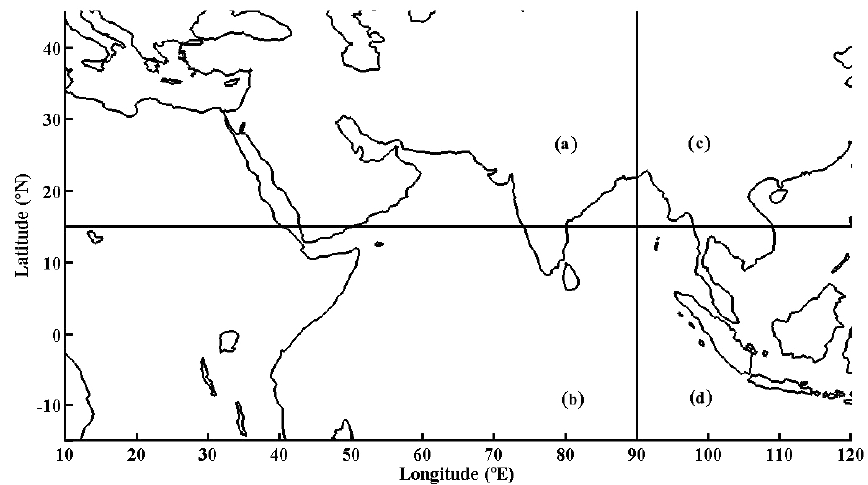
Figure 5. Regions representing the various aerosol sources for a point over the Bay of Bengal. (a) the India/Arabian Peninsula, (b) the Indian Ocean, (c) northern/northeastern India and East Asia and (d) Southeast